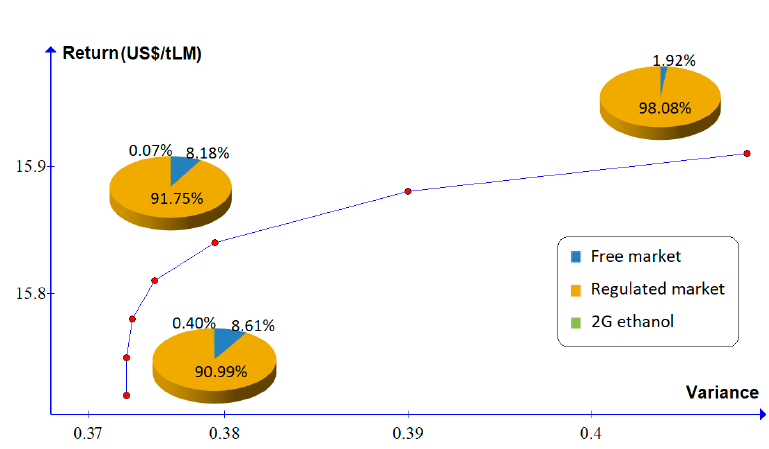
Figure 3. Efficient frontier for the base scenario.